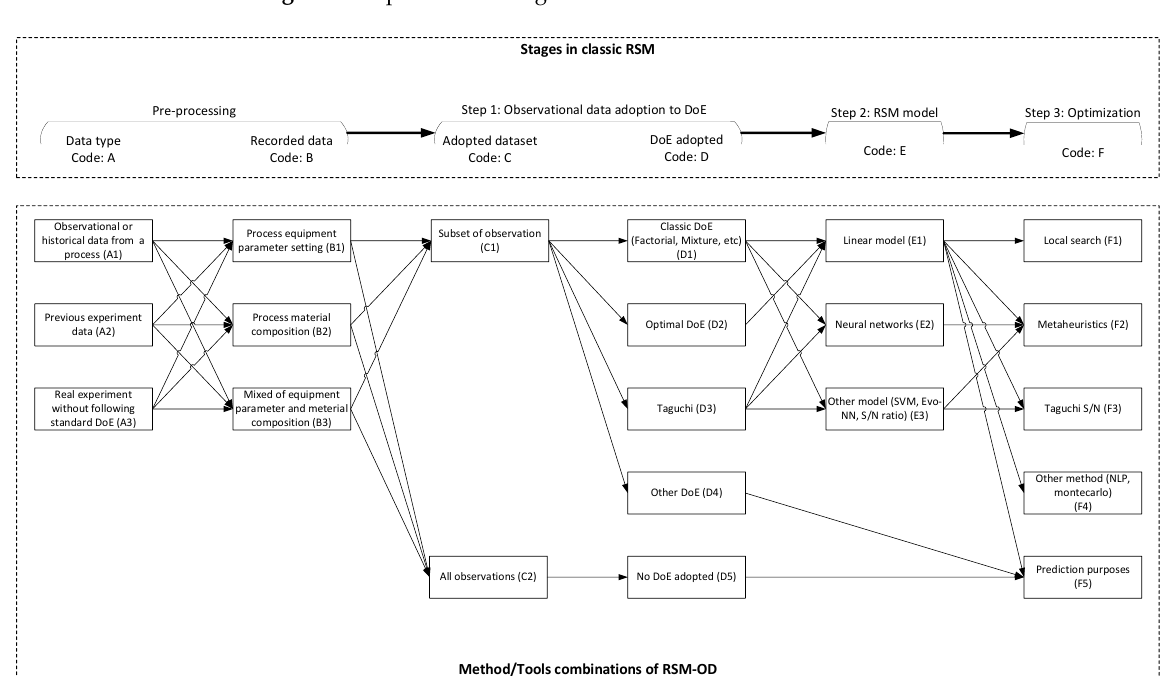
Figure 13. Combination of the methods adopted in